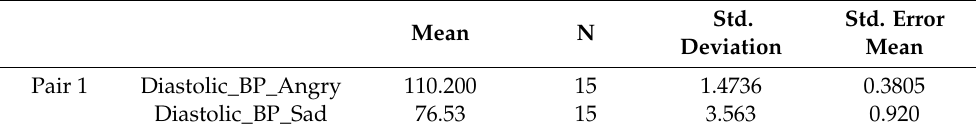
Table 12. Paired samples statistics for diastolic bp (angry to sad state). Mean N